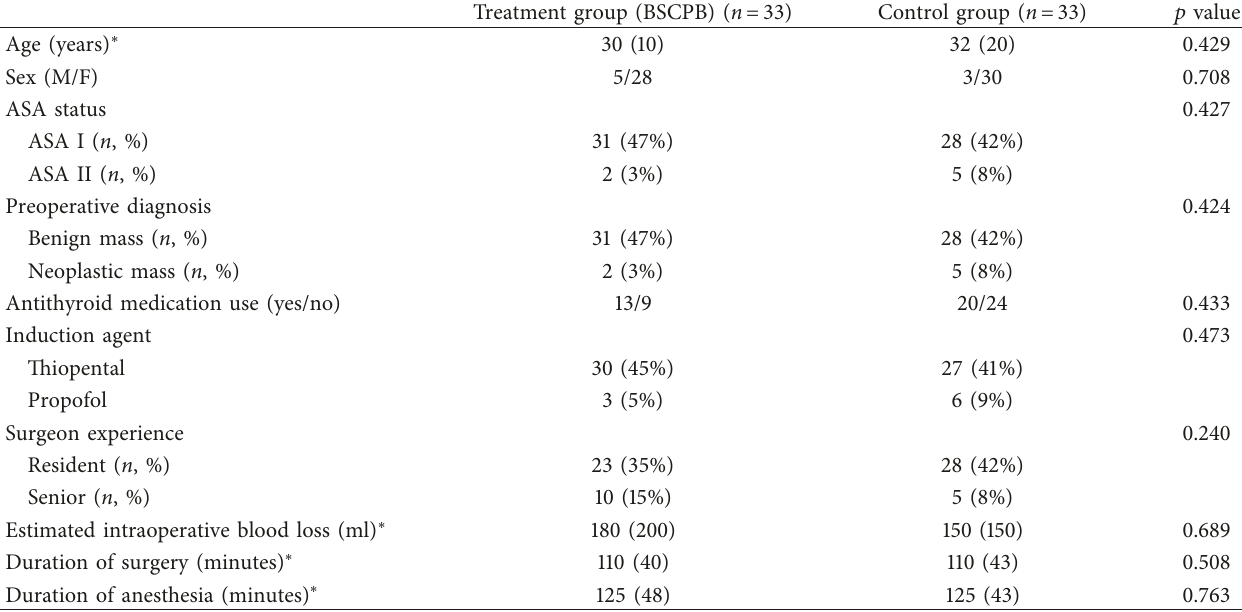
Table 1: Demographic and intraoperative characteristics of patients.